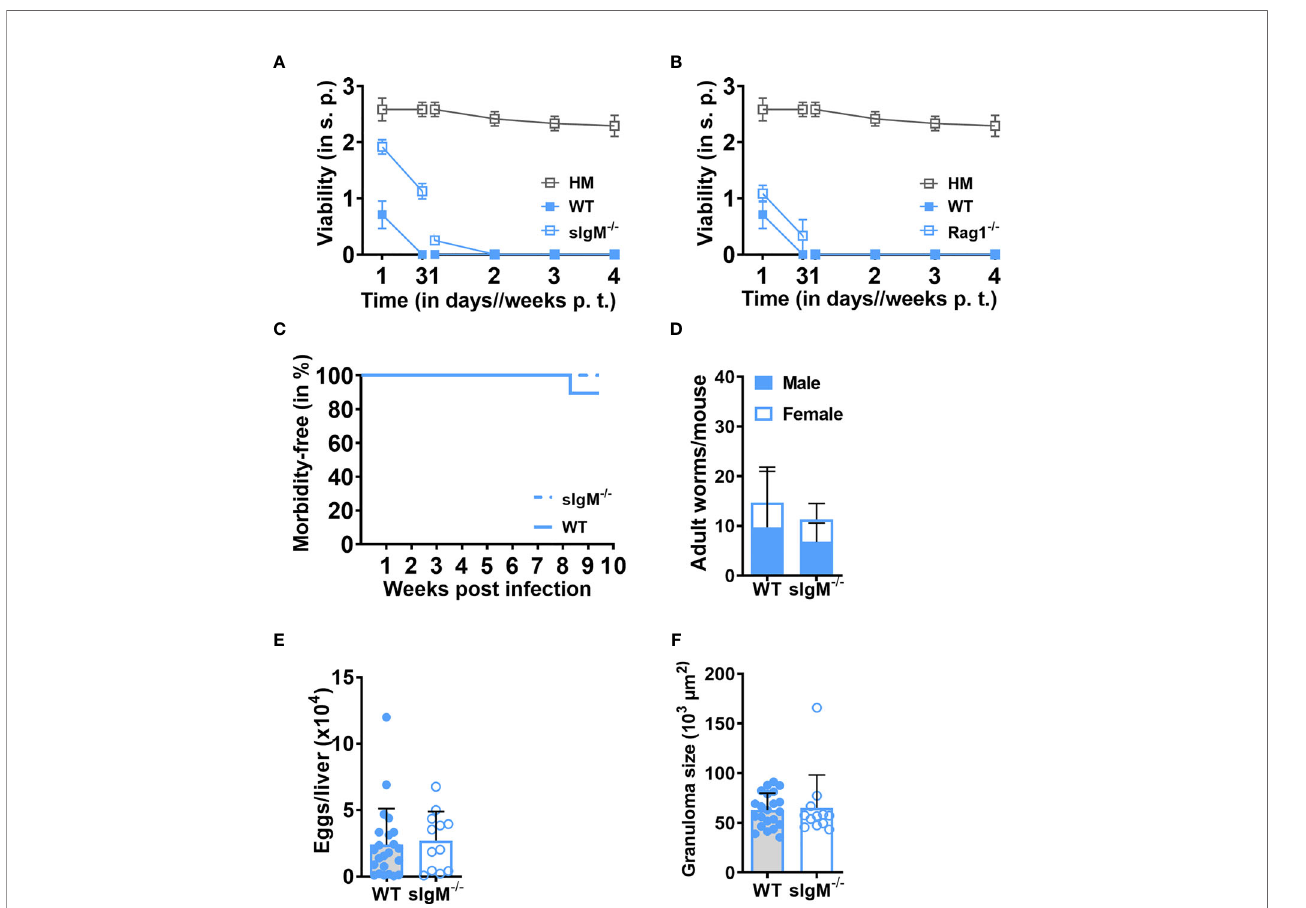
FIGURE 4 | Unspeci fi c immunoglobulins (Igs) have no impact on the viability of S. mansoni NTS. NTS were cultured and maintained using hybridoma medium (HM) supplemented with 20% sIgM -/- , Rag1 -/- , or wild-type mouse (WT) sera at 37°C in 5% CO 2 for four weeks. HM alone was used as a control. (A) Viability of NTS is not restored by the loss of soluble IgM (sIgM) or (B) Igs. Results are representative of at least three individual experiments. Each data point has been shown as mean ± SD of at least three technical replicates. (C) Loss of sIgM does not signi fi cantly in fl uence the mortality of S. mansoni -infected mice. sIgM-de fi cient mice were infected by injecting 200 cercariae and survival of the animals was monitored on a weekly basis. (D) Worm maturation was not affected by the de fi ciency of sIgM. After ten weeks of infection, the animals were euthanized and mature worms from mesenteric veins were fl ushed out, enumerated and male/female ratio was determined. Shown data is the mean ± SD of worms per mouse. (E) Lack of sIgM does not affect the fecundity of the worm. Eggs from the liver were isolated and counted. (F) sIgM does not in fl uence the egg-induced immunopathology of the worm. Liver sections (4 µm) from infected wild-type or sIgM -/- mice were stained with Masson ’ s Blue and the diameter of 30-40 granulomas/section was measured microscopically (10x). Data shown is pooled data from fi ve individual experiments (WT, n=28; sIgM -/- , n=12). Each data point shows a single mouse. Mean ± SD is indicated with bars. p.t., post transformation. s.p.,